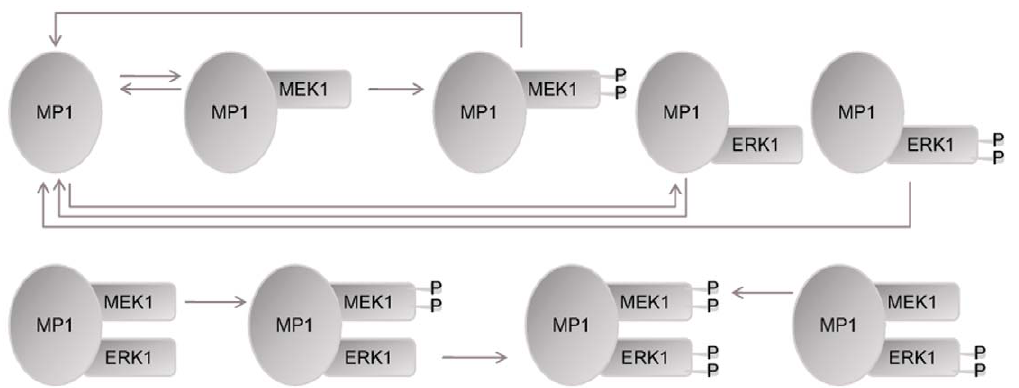
Figure 3. A detailed biochemical model of scaffolding action of MP1. Please refer to ‘‘Methods’’ for the considerations and assumptions used and Supplementary Table S1 for detailed descriptions of their kinetics parameters. ‘‘P’’ denotes protein phosphorylation.